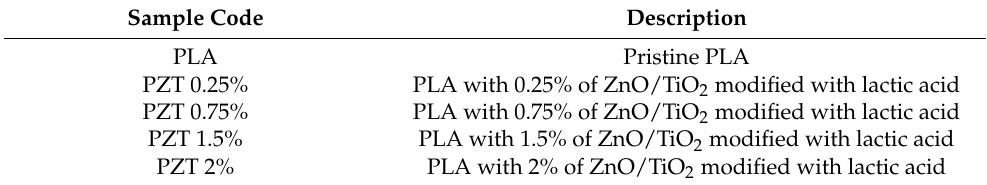
Table 1. Identification of the PLA-ZnO/TiO 2 nanocomposites with different percentages of additives (0, 0.25, 0.75 and 2